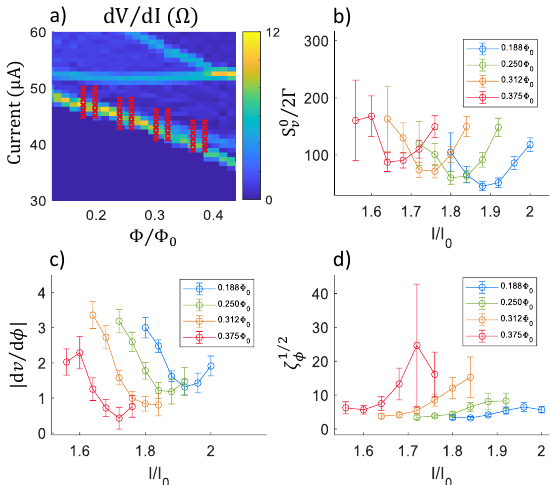
Figure 5. Noise calculations for an undamped SQUID along the critical curve: ( a ) Plot of dV / dI vs. current ( I ) and flux ( Φ ). The crosses correspond to the values of I and Φ for which noise was calculated. There are two sets of crosses, separated by 0.02 Φ 0 , to enable the calculation of the derivative dv / d φ at each flux value. ( b ) Plots of the dimensionless low-frequency voltage noise power S 0 v /2 Γ vs. current I for four different flux values. ( c ) Plots of the dimensionless transfer junction | d ν / d φ | . ( d ) Plots of the dimensionless flux noise ζ 1/2 . The schematic used for these calculations was that of Figure 3a, with φ I 0 = 25 µ A, L m = 30 pH, R J = 2 Ω , L p = 4 pH, C J = 10 fF, C p = 8 pF, and T = 4.2 K.